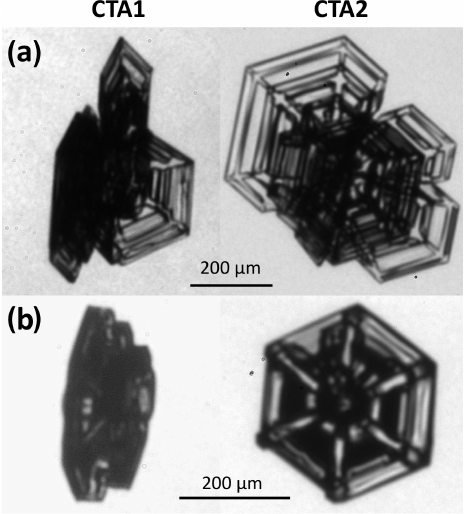
Figure 11. Two examples of stereo images for plate-like ice crystals captured in ice precipitation underneath an Arctic mid-level cloud. Images captured in the Camera Telescope Assembly 1 (CTA1) are depicted on the left side; the corresponding images of the same crys- tal captured in CTA2 are shown on the right side. The examples nicely show the advantage of having a second view of the